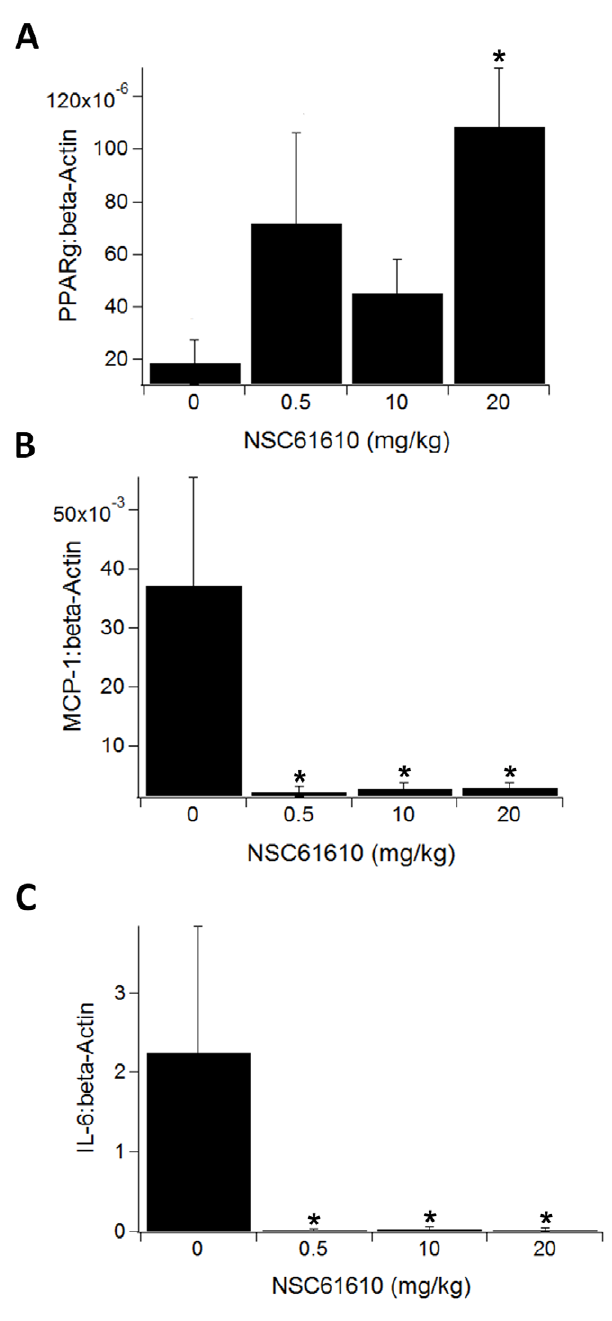
Figure 5. Modulation of colonic gene expression by oral treatment with NSC61610. Mice were challenged with 2.5% dextran sodium sulfate in the drinking water for 7 days. Colonic mRNA expression of peroxisome proliferator-activated receptor c (PPAR c ) (A), monocyte chemoattractant protein-1 (MCP-1) (B), and interleukin-6 (IL- 6) (C) were assessed by quantitative real-time RT-PCR. Data are represented as mean 6 standard error (n=10). Bars with an asterisk indicate that a treatment is significantly different from its control ( P , 0.05 ). doi:10.1371/journal.pone.0034643.g005 inflammatory lesions. Our data indicate that NSC61610 signifi- cantly reduced macroscopic inflammatory lesions in PPAR c - expressing and T cell-specific PPAR c null mice with DSS colitis (Fig. 8B, 8C and 8D). However, the therapeutic effect of